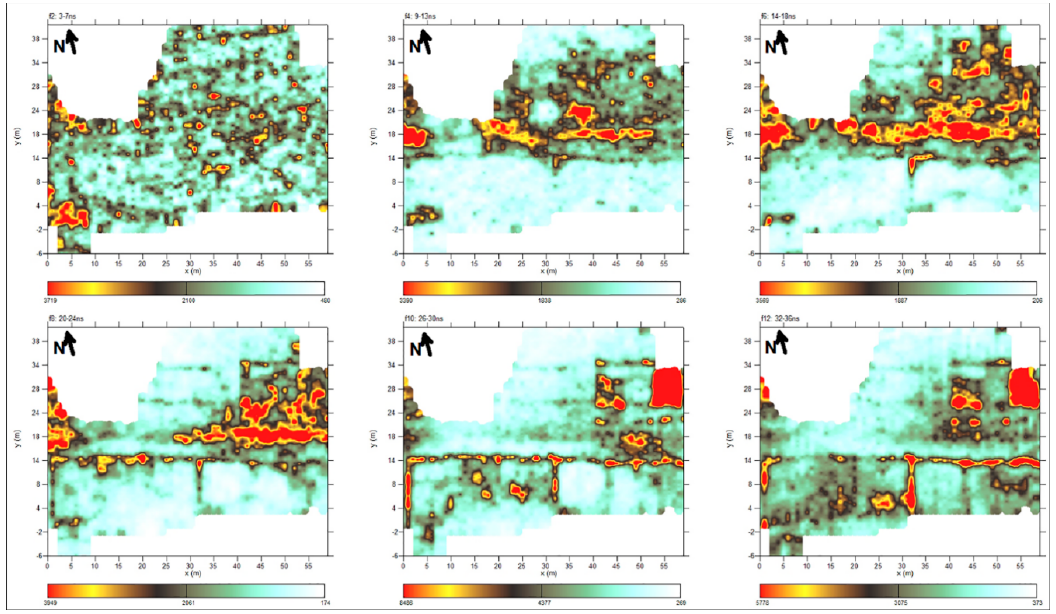
Figure 9. Doclea: a selection of time slices relative to the northern part of the capitolium (3 in Figure 10). The colour scale indicates the measured variation of the amplitude of the electromagnetic signal.